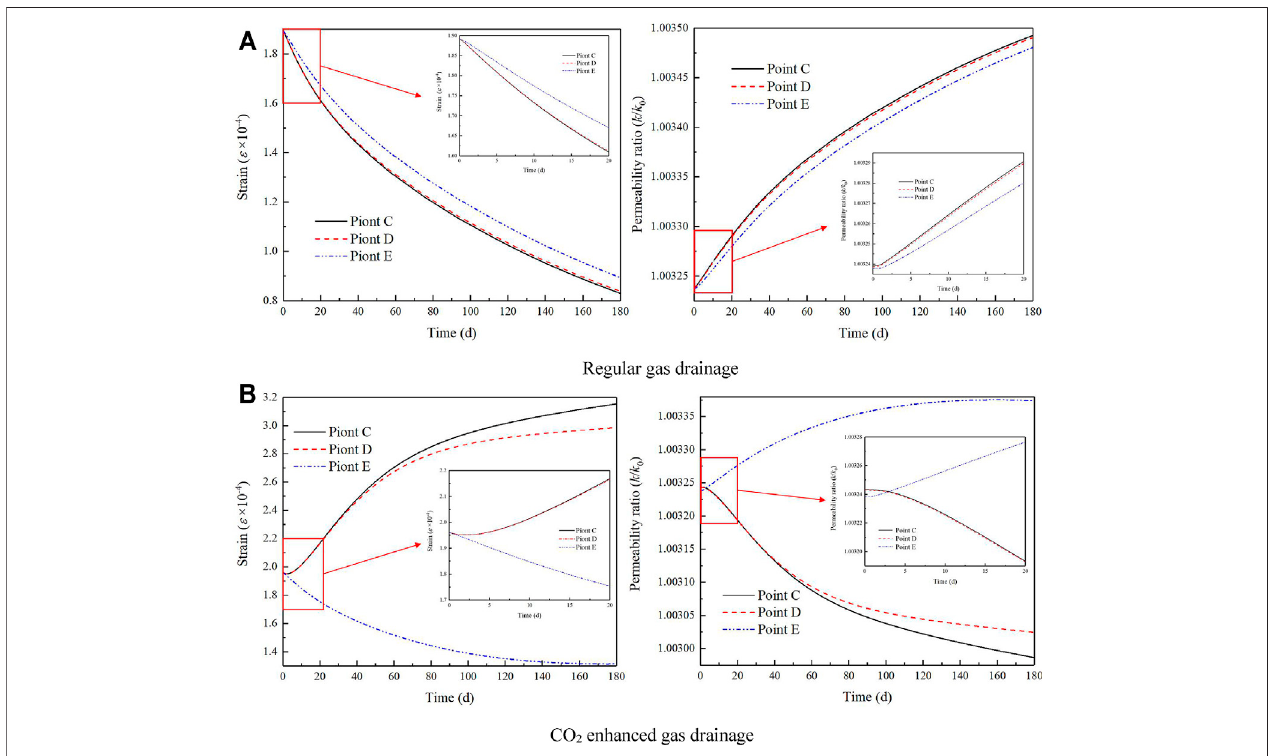
FIGURE 6 | Changes in strain and permeability of coal skeleton on the reference points (C, D, E) during regular and CO 2 enhanced gas drainage. (A) Regular gas drainage. (B) CO 2 enhanced gas drainage.